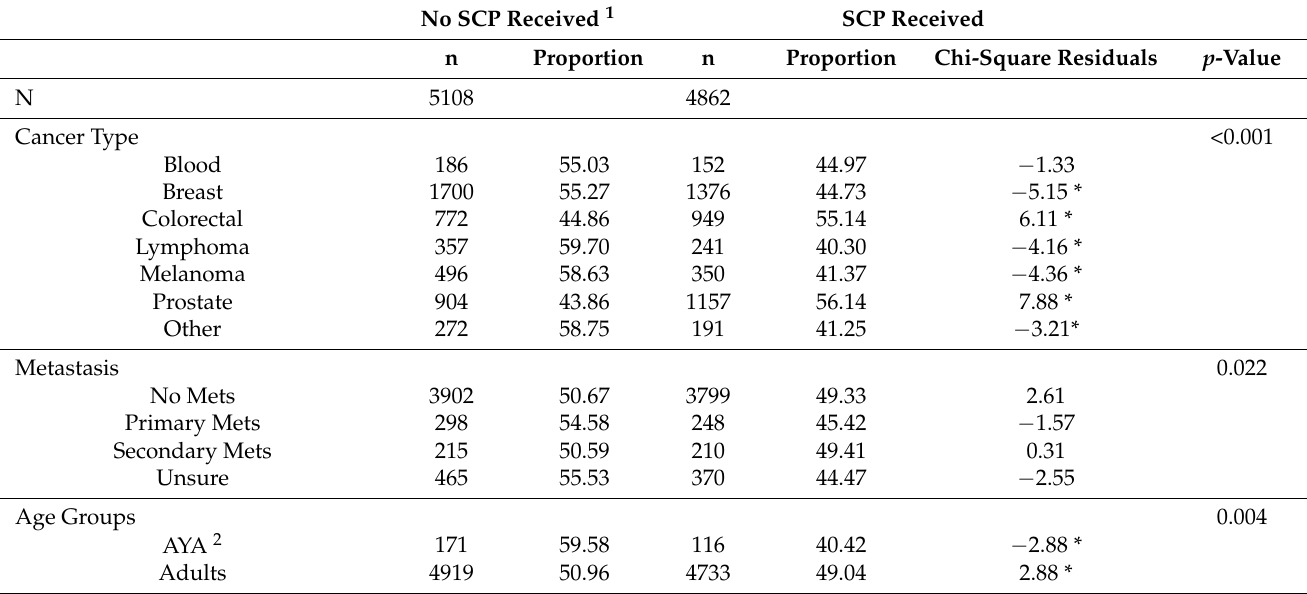
Table 1. Chi-squared analysis of sociodemographic factors and survivorship care plan (SCP).